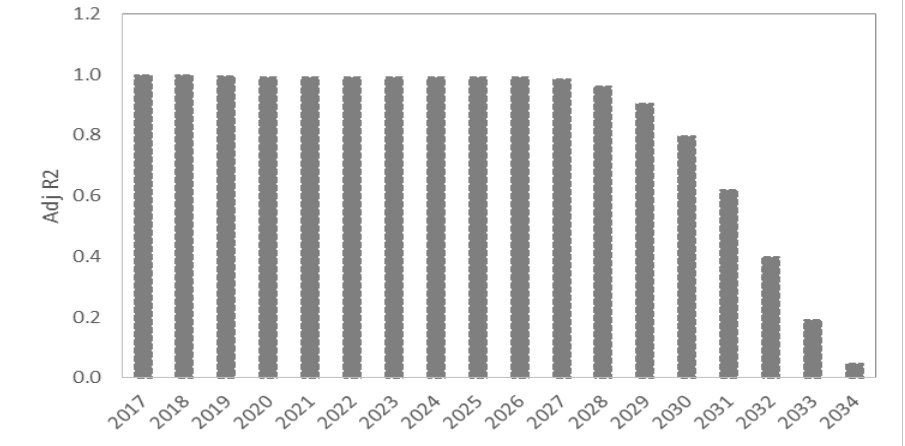
Correlation (adjusted R-squared value) between the system dynamics (SD) and neural-network (NN) forecast of steel